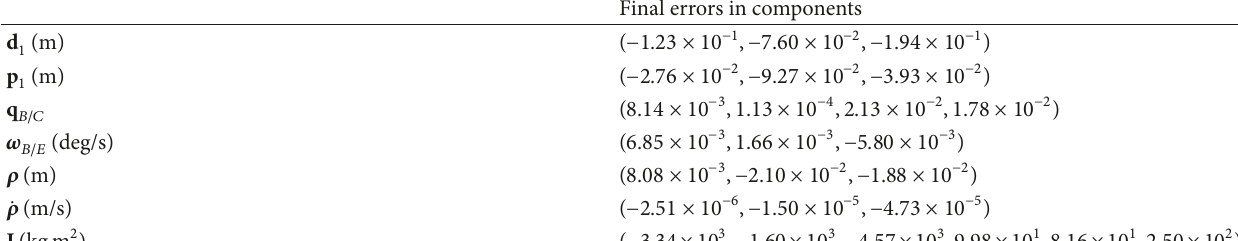
Table 1: Errors in components at the end of the simulation 𝑡 𝑓 = 5828 s. Final errors in components